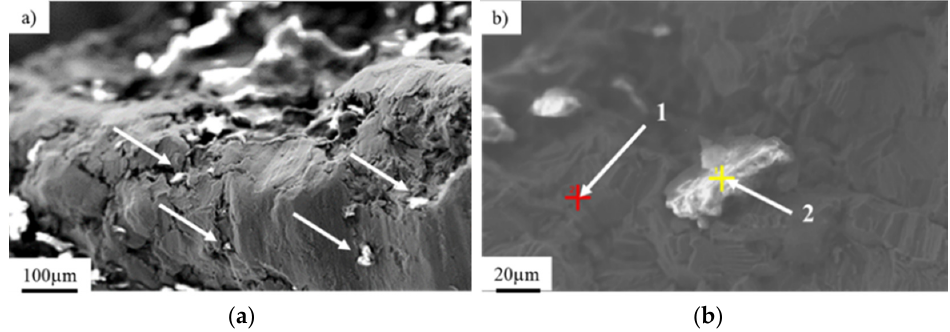
Figure 3. View of inclusions and precipitates on the implant surface and near the fracture zones ( a ); enlarged view of the inclusions on the implant surface ( b ).